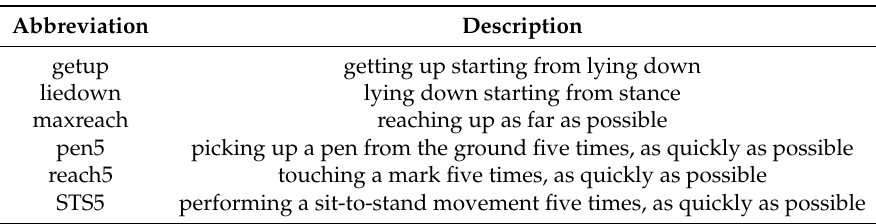
Table 1. Description of the activities.